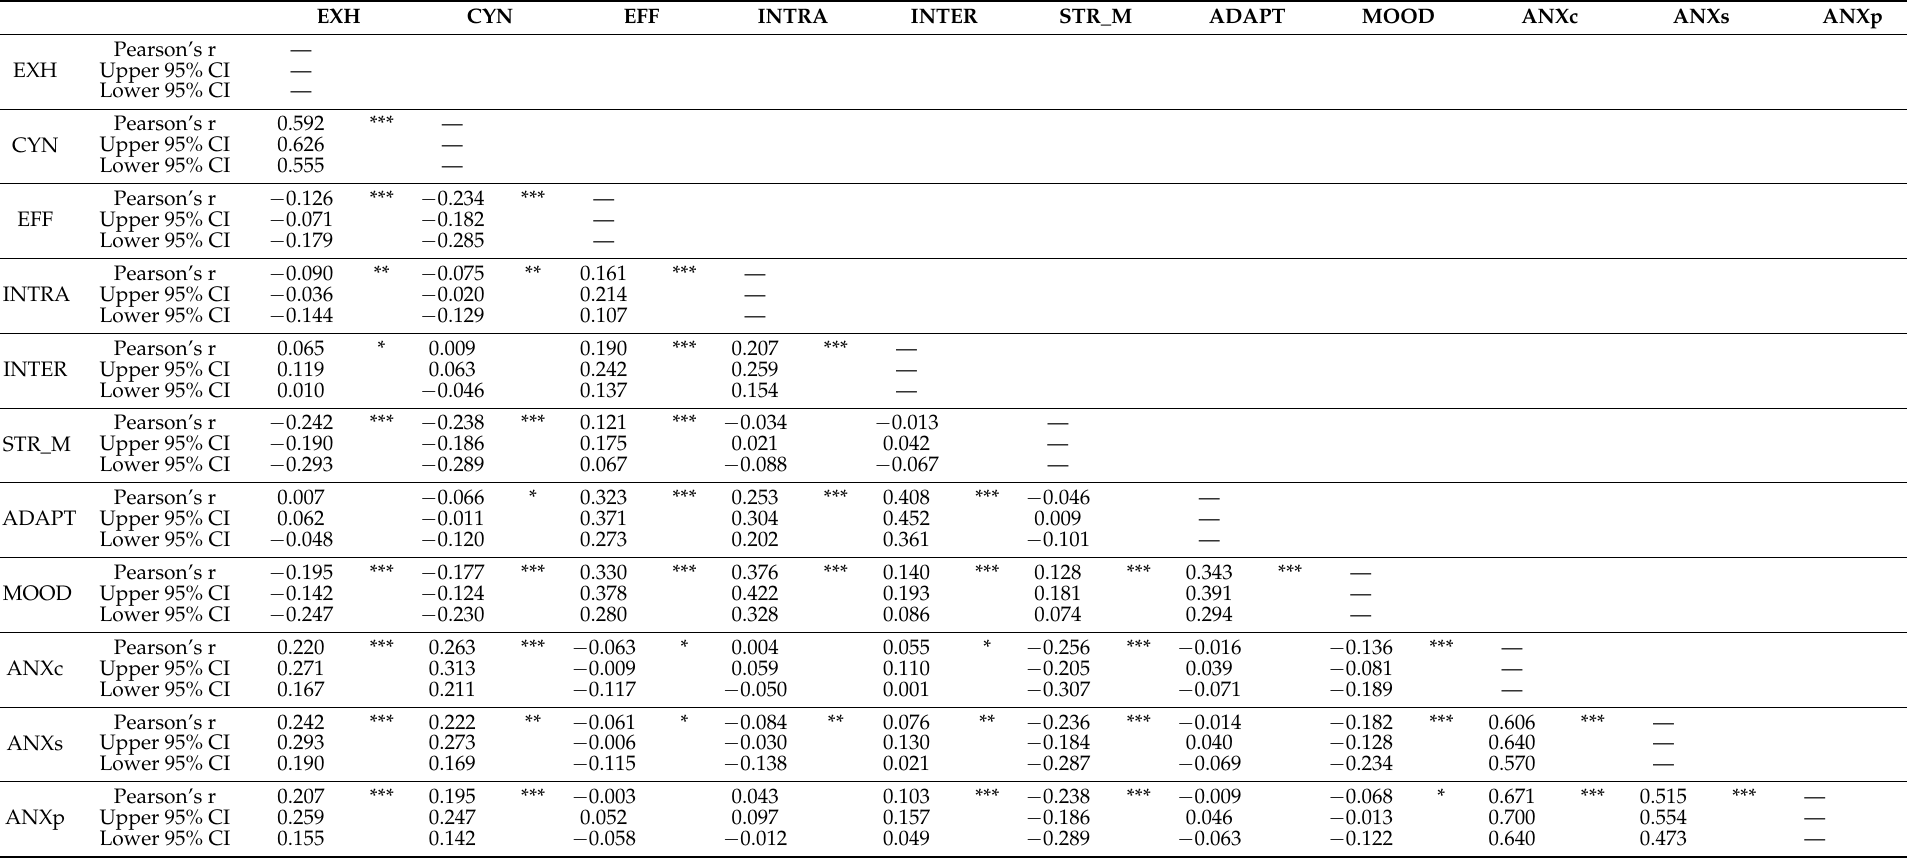
Table 1. Bivariate correlation